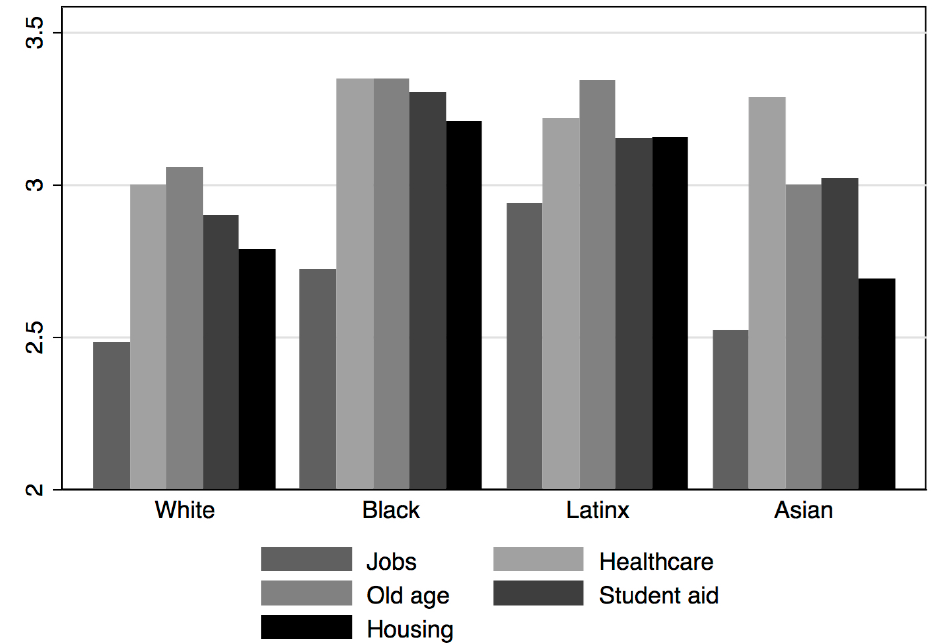
Figure 4. Support for social policies by race/ethnicity (Index 2 questions).